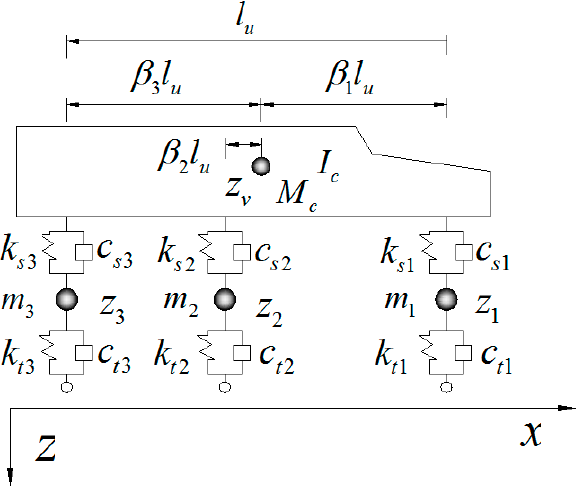
Figure 5. Vehicle model with three-axis. Table 1. Parameters of the vehicle.